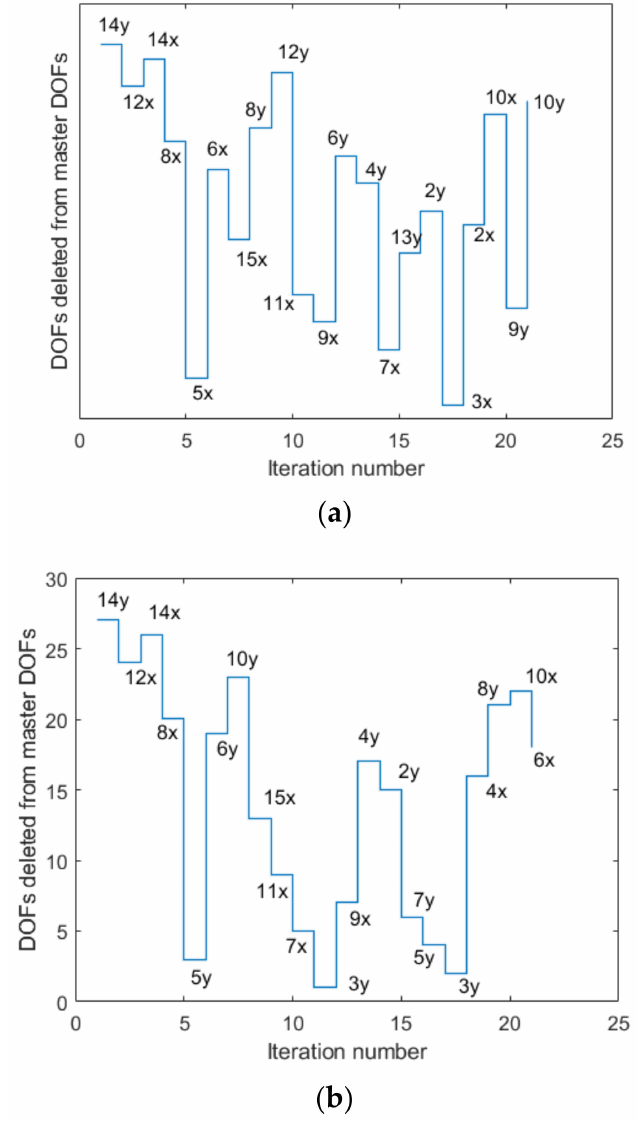
Figure 4. DOFs deleted from master DOFs: ( a ) MAC method; ( b ) EI method.